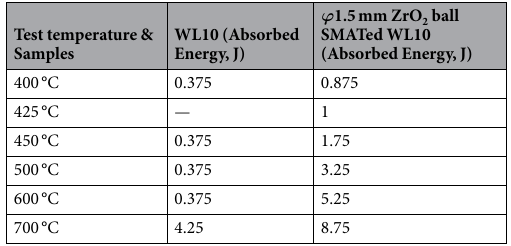
Table 3. The absorbed energy as a function of the test temperature of the WL10 and the ϕ 1.5 mm ZrO 2 ball SMATed WL10.